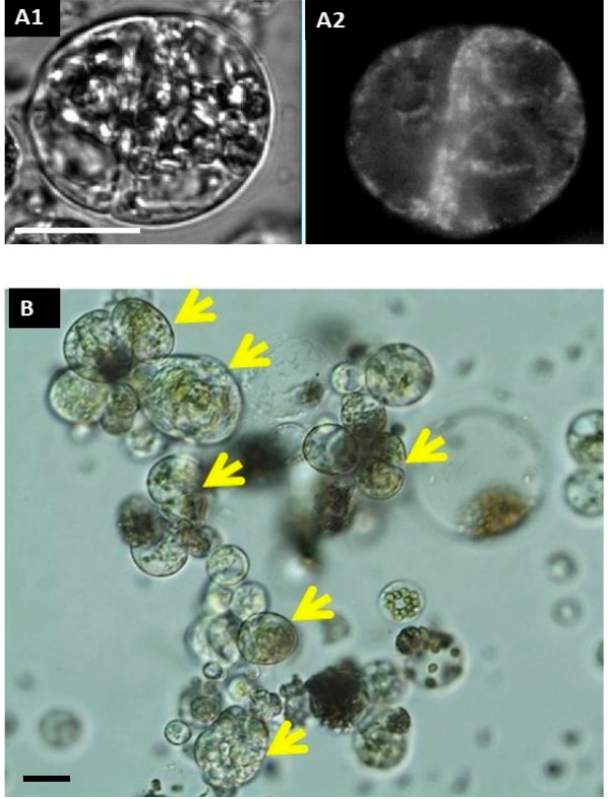
Figure 2. Cell division and microcolony formation. Tracking of the first cell division with rhd123 After a 2 h incubation: ( A1 ) DIC (differential interference contrast); ( A2 ) rhd123; ( B ) microcolony formation at 96 h after isolation. Scale bar: 20 µ m. Yellow arrows mark compact colony.